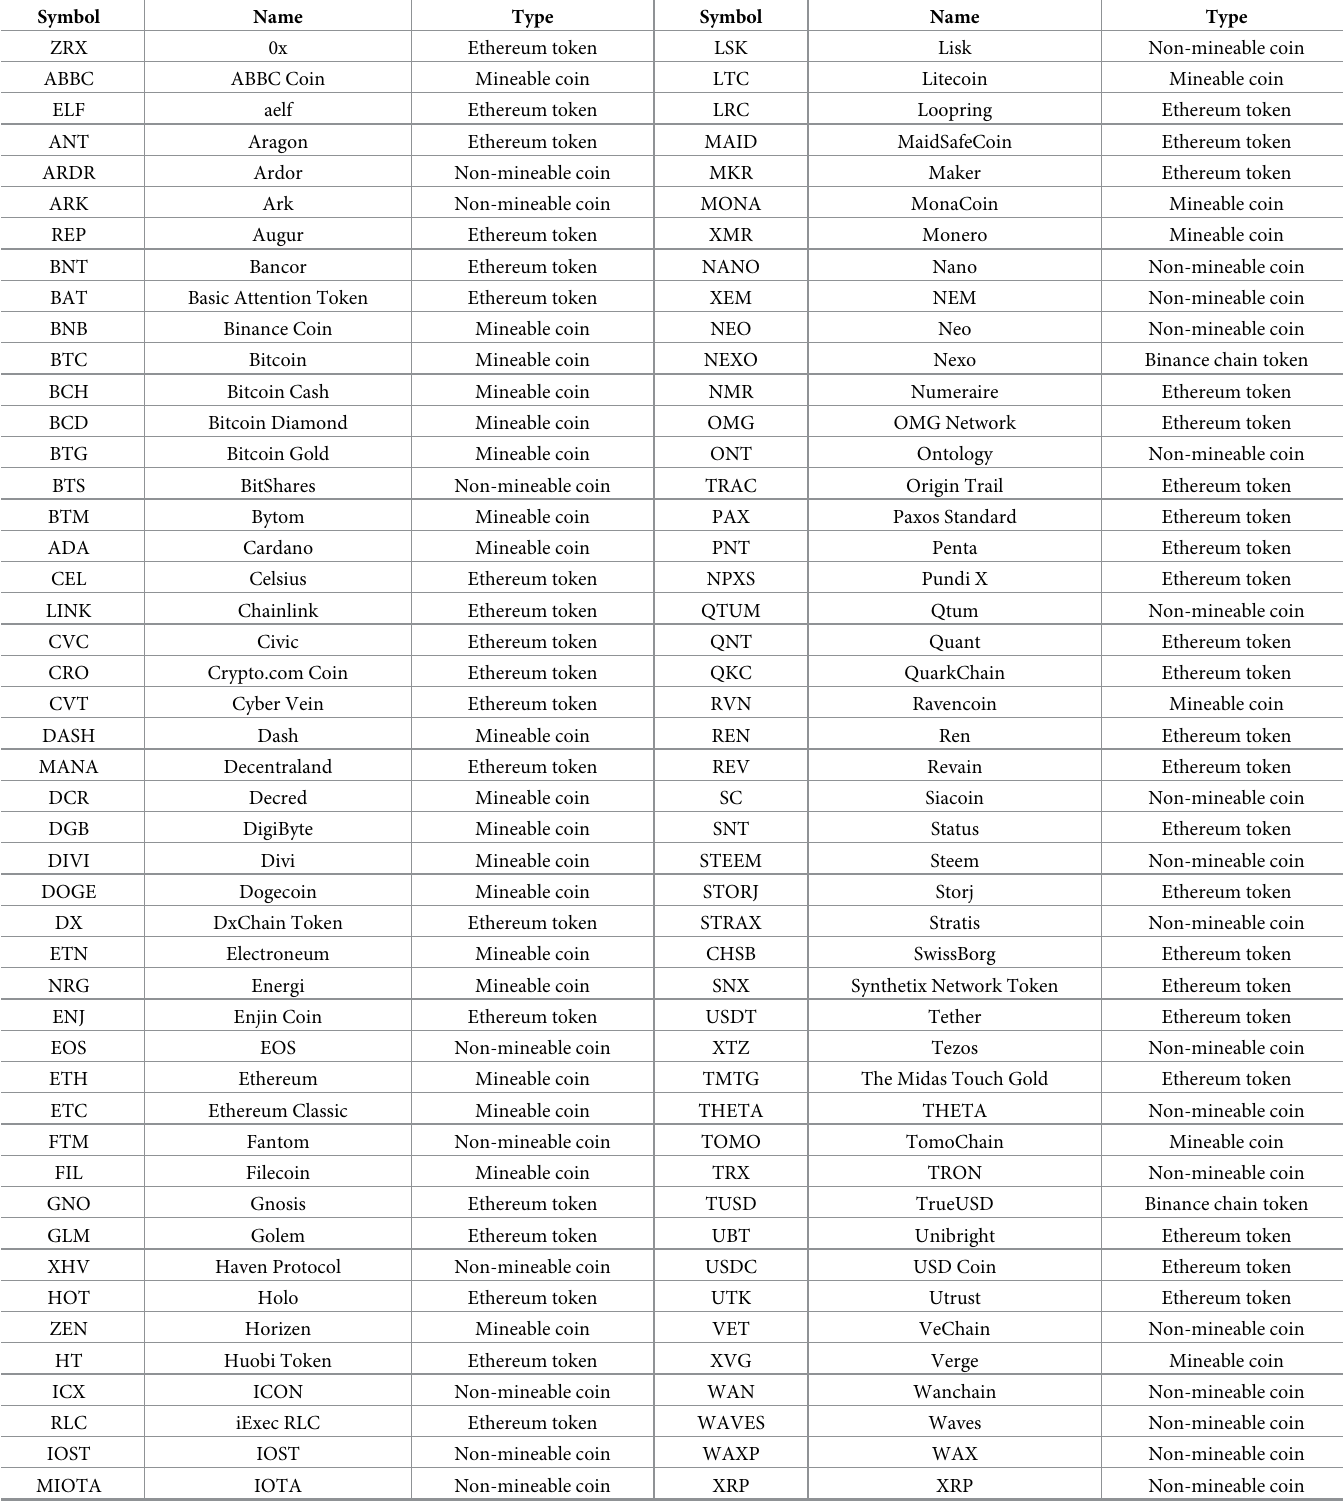
Table 1. Cryptocurrency